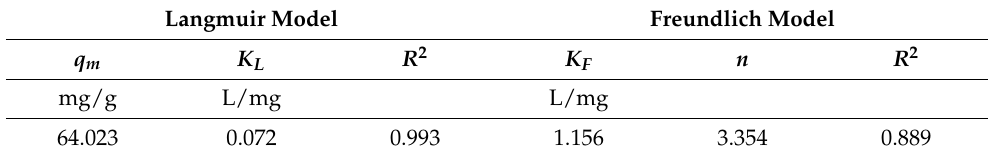
Table 2. Parameter table of adsorption isothermal model of 5 wt% CTS-MMT composite fiber membrane. Langmuir Model Freundlich Model